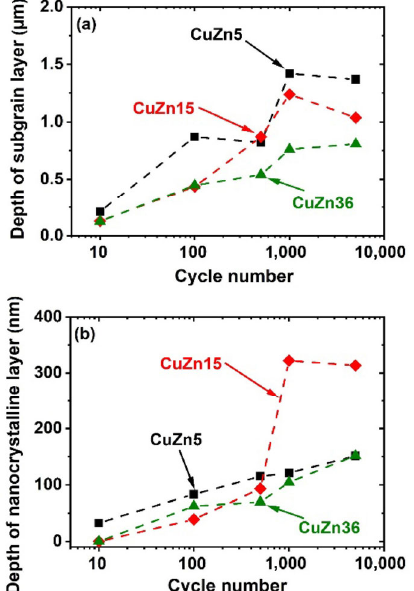
Fig. 8 Depths of the surface layers developed during the tribological loading of Si 3 N 4 spheres on CuZn5, CuZn15, and CuZn36 samples. The depth of (a) the sub-grain layer and (b) the nanocrystalline layer is plotted as a function of sliding cycle number, the latter on a logarithmic